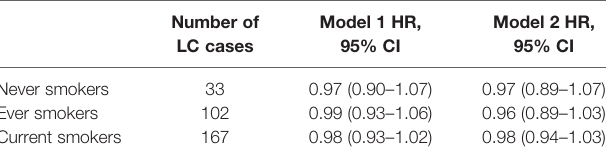
TABLE 4 | Hazard ratio ’ s (95% CI) for BMI (kg/m 2 ) and the risk of lung cancer in never, ever and current smokers.